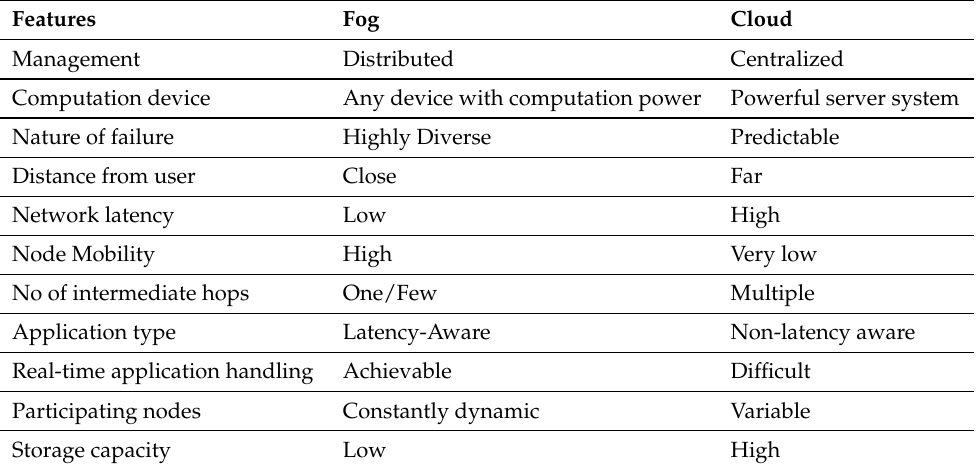
Table 1. Limitations of CC and